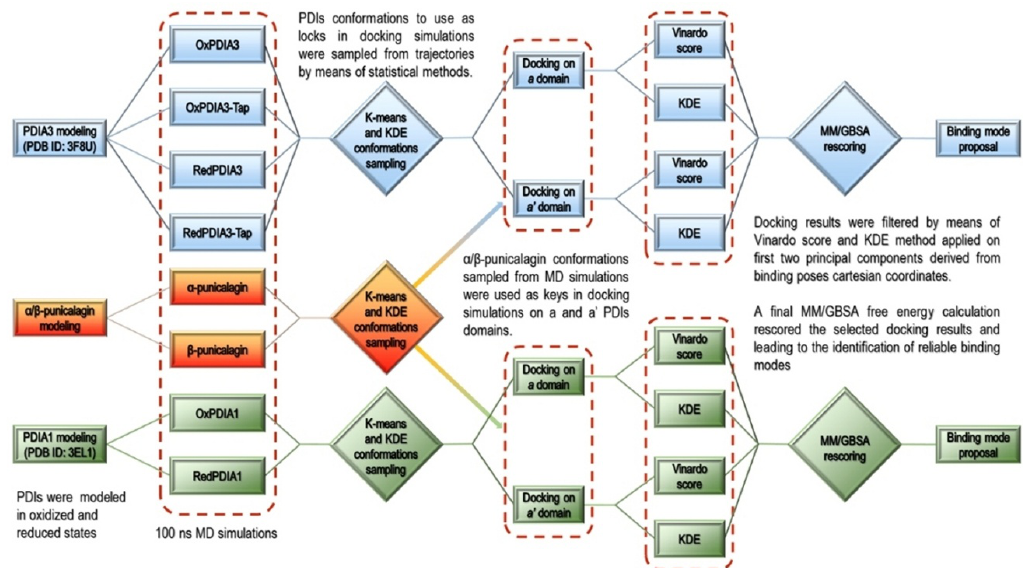
Figure 5. Scheme of the computational chemistry procedure conducted to provide a putative binding mode for punicalagin on PDIA3 and PDIA1. See text for details.